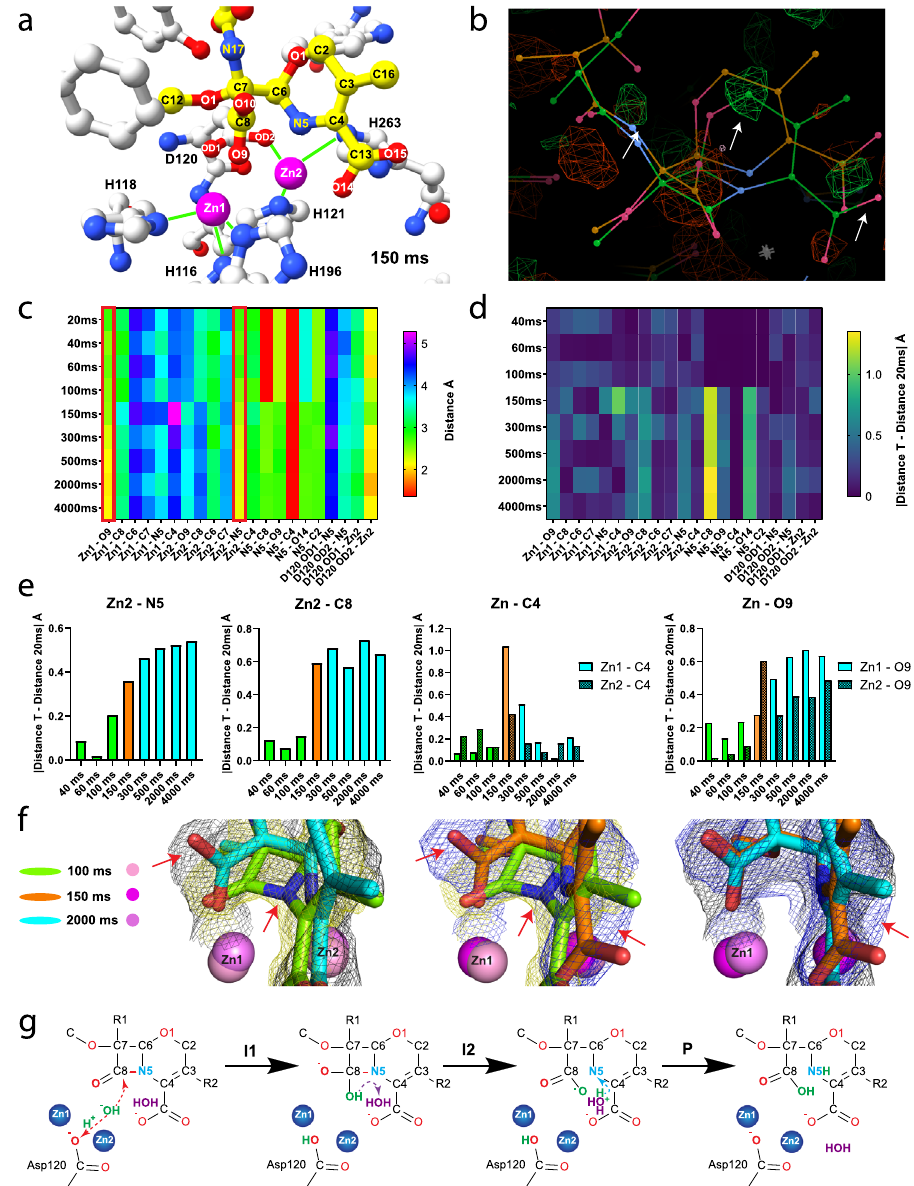
Fig. 4 | TR-SSX crystal structures of moxalactam of the active site of L1 MBL. a L1 active site structure at 150ms with hydrolyzed moxalactam (in yellow-red- blue), zinc (magenta) and protein residues (in silver-blue-red). b Difference elec- tron density mapcalculated asF obs (150ms)-F obs (100ms).The differentialmap was calculated with Phenix isomorphous difference maps module. Negative electron densityshowedasredmesh,positiveasgreenmesh.DepictedintheCootelectron density map are countered with a 1.9 σ level. Orange lines illustrate cleaved mox- alactam at 150ms, green lines represent uncut moxalactam at 100ms. c Distances between atoms key in description of L1 induced β -lactam cleavage reaction